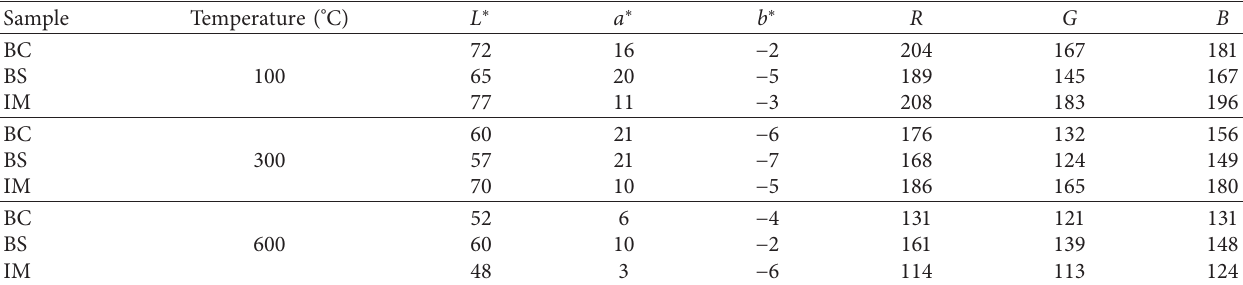
Table 2: Conversion of L ∗ a ∗ b ∗ space color to RGB color codes.